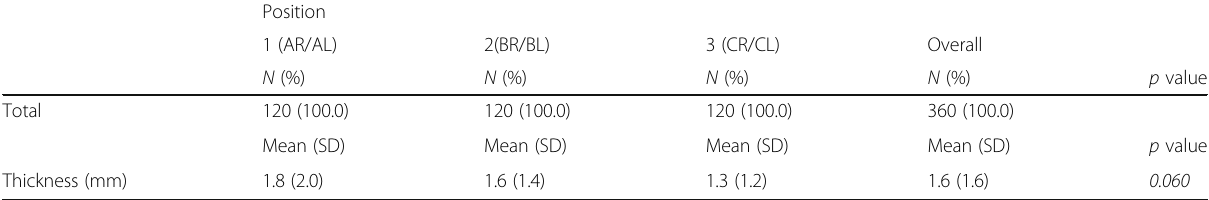
Table 3 Thickness by point of measurement (all